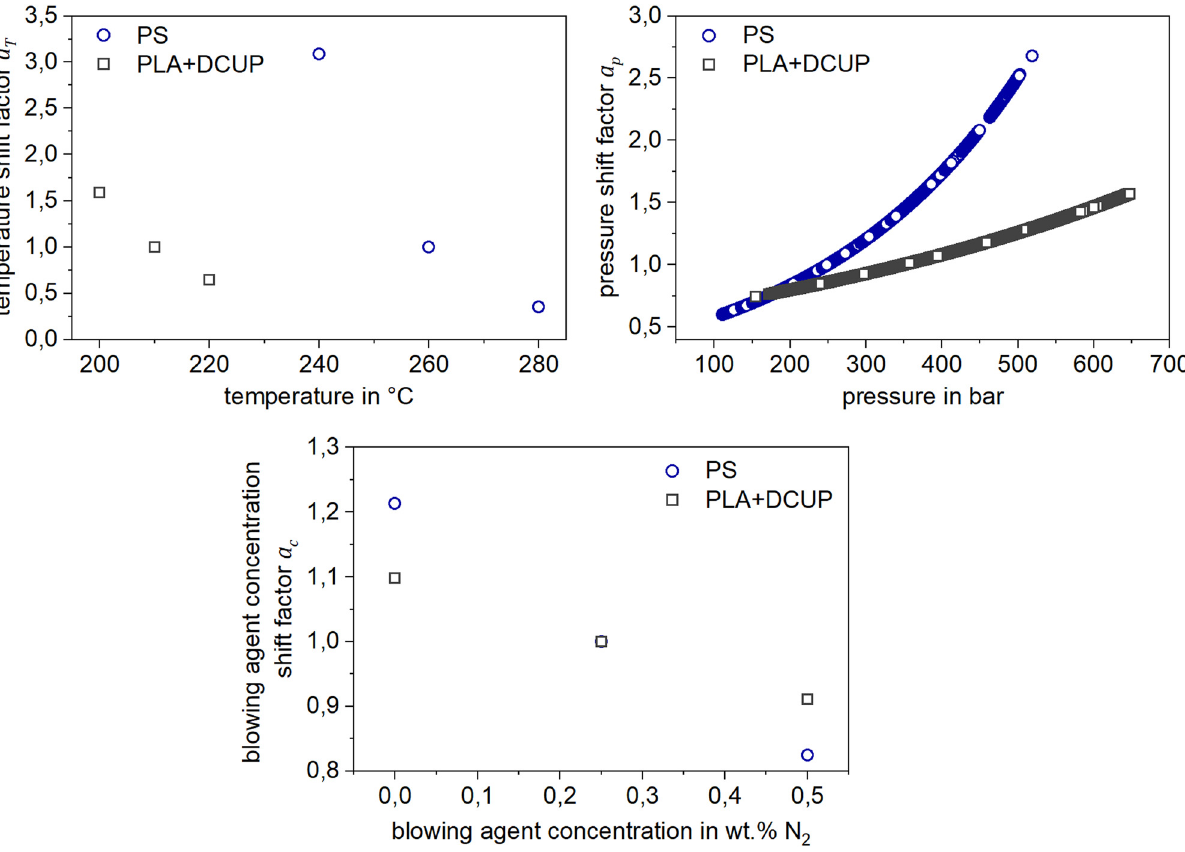
Figure 7: Overview of the shift factors a T , a p , and a c used to reach the master curve of the measurement data gathered by in - line viscosity